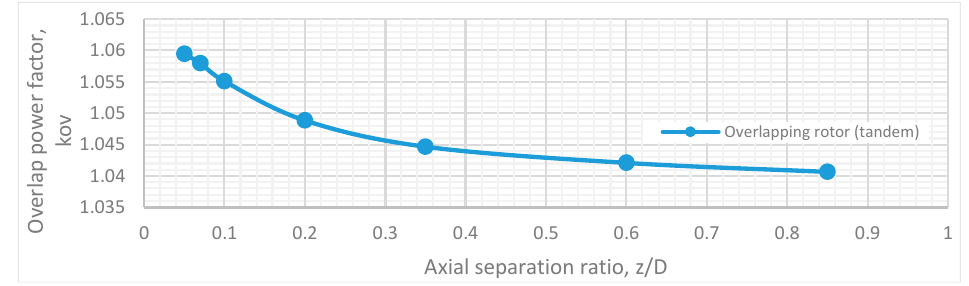
Figure 21 . Effect of axial separation z / D at partial rotor overlap d / D = 0.85 (overall thrust, 8 N).